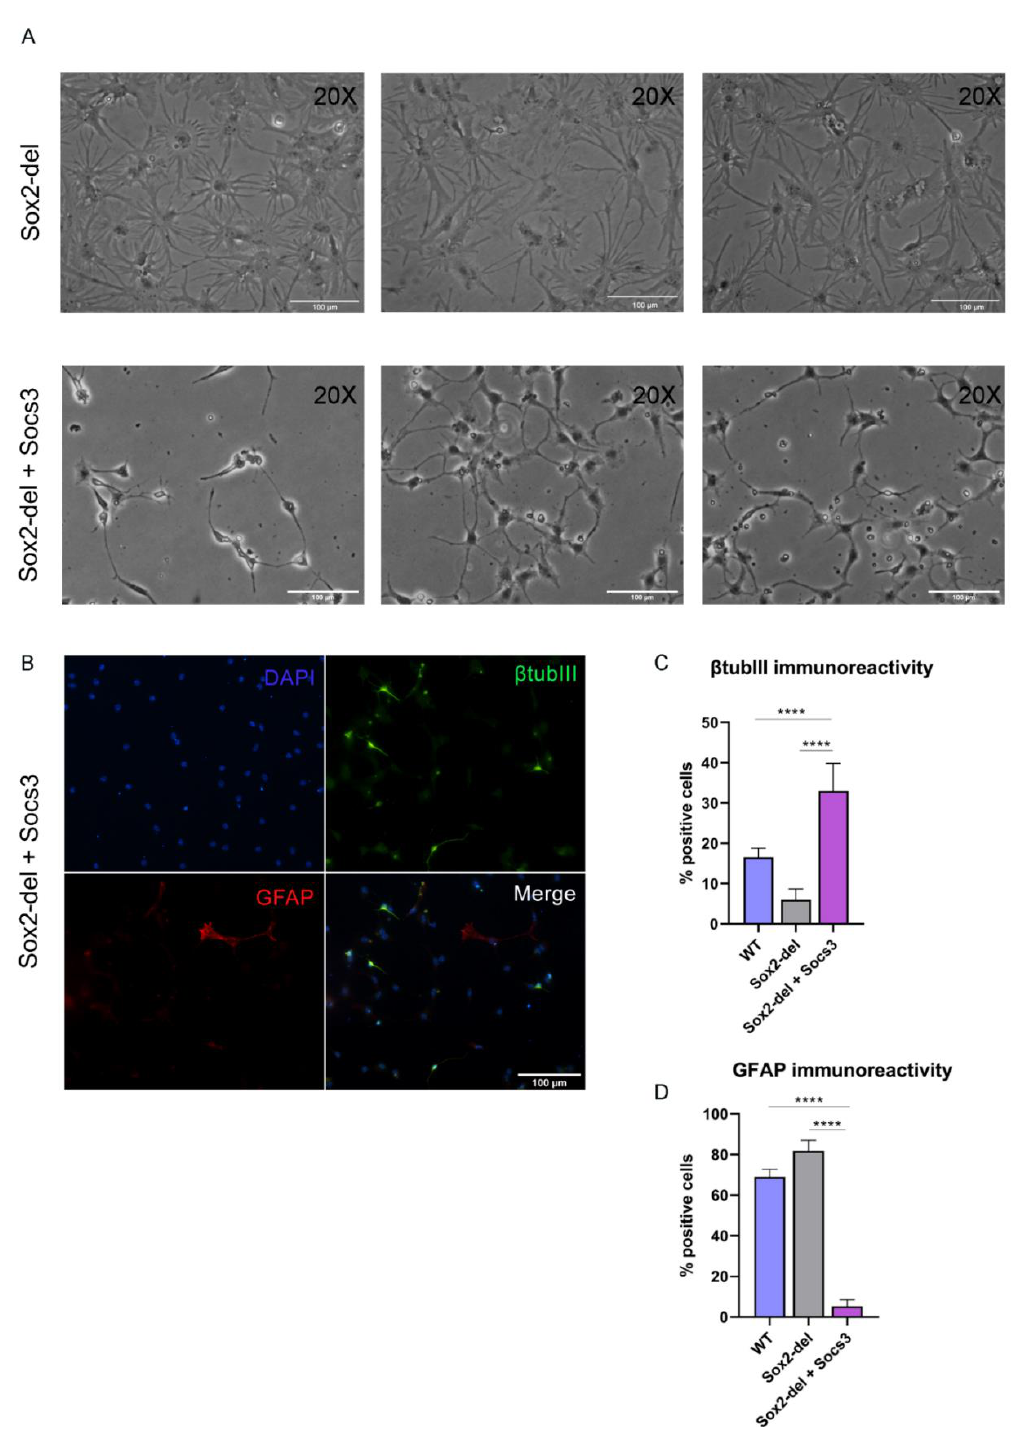
Figure 3. Lentiviral expression of Socs3 in Sox2-del NSC inhibits gliogenesis upon induction of differentiation. ( A ) Bright- field microscopy of Sox2-del cells (top row) and Socs3 -transduced Sox2-del cells (Sox2-del + Socs3; bottom row) at differ- entiation day 11. Sox2-del + Socs3 cells (bottom) are strongly abnormal, and no longer display glial morphology ( B ). IF of Sox2-del + S ocs3 cells; most β -tubulinIII-positive cells, although present, do not show neuronal morphology and most of them are weakly stained. GFAP-positivity is essentially absent (compare to Figure 1). ( C , D ) Histograms show the percent- age of β -tubulinIII and GFAP-positive cells/total cell number. Results are the mean of 16 fields counted in n = 2 independ- ent differentiation experiments. Statistical significance was assessed by Brown Forsythe ANOVA and Dunnet T3 test (**** p < 0.0001; ns: not significant).